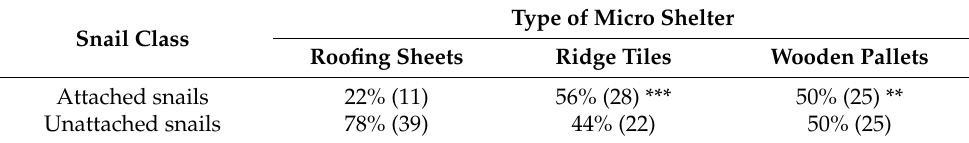
Table 1. Distribution of snail classes concerning their preference for micro shelters